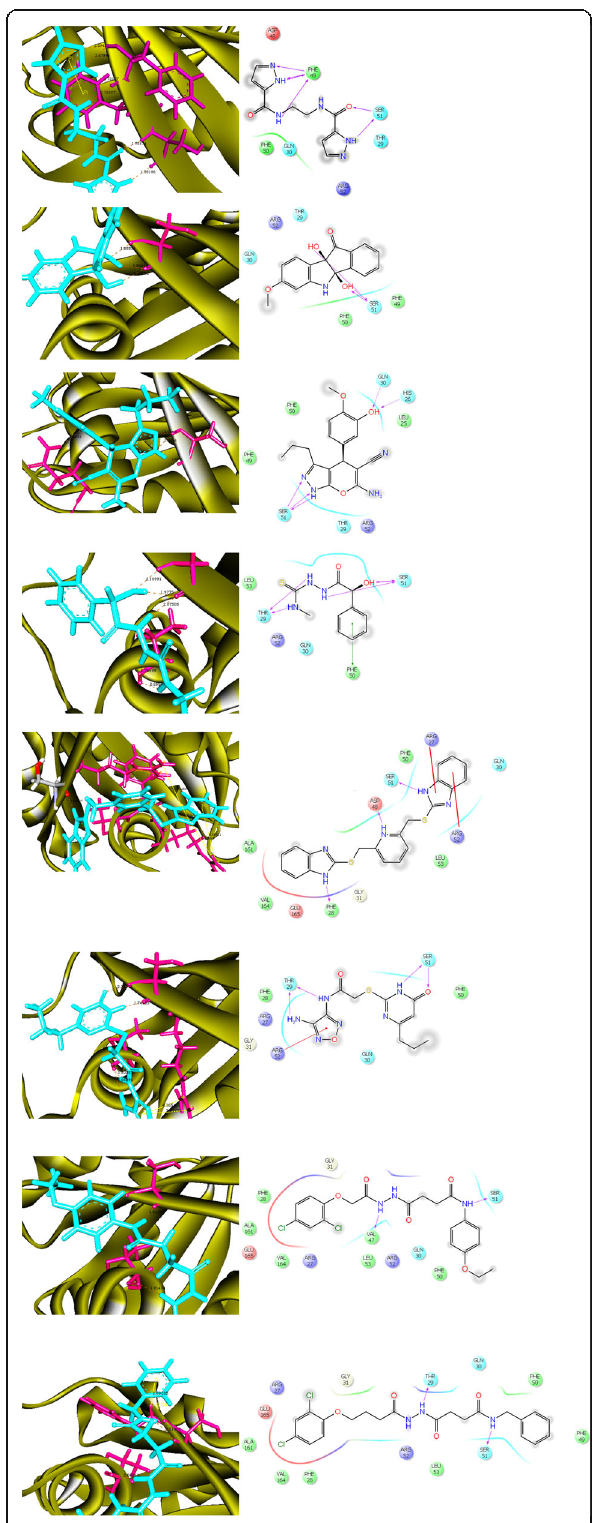
Fig. 11 Docked structures of top eight hits with Rab39a (i) three- dimensional [26] and (ii) two-dimensional depicting the interactions between Rab39a and ligand molecules: (i) Rab39a protein is represented in gold color, binding residues in pink stick, and the ligands in cyan stick model. The H-bonds are in brown, and π interactions in yellow color. (ii) The residues are shown in a three-letter code, H-bonds in pink lines, and π - π in green